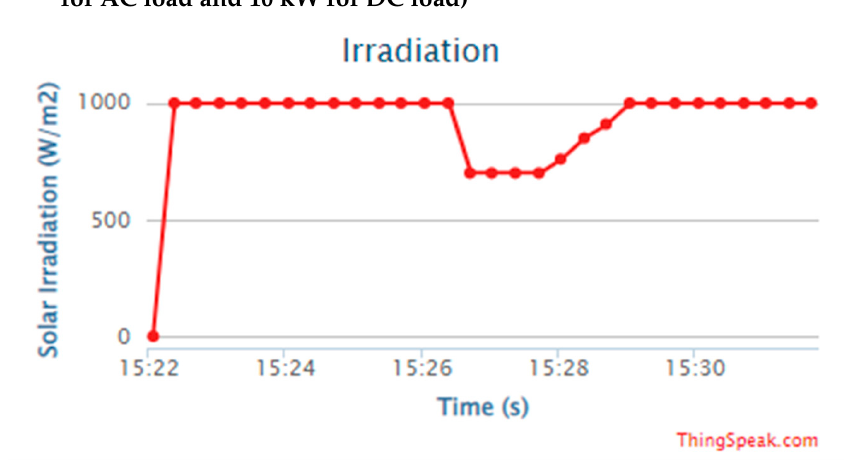
Figure 10. Proposed solar irradiation profile.